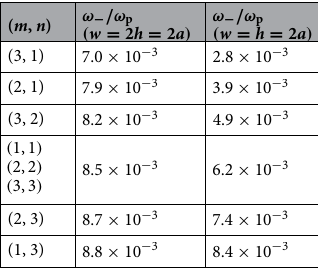
w ) with PEC boundaries and filled =